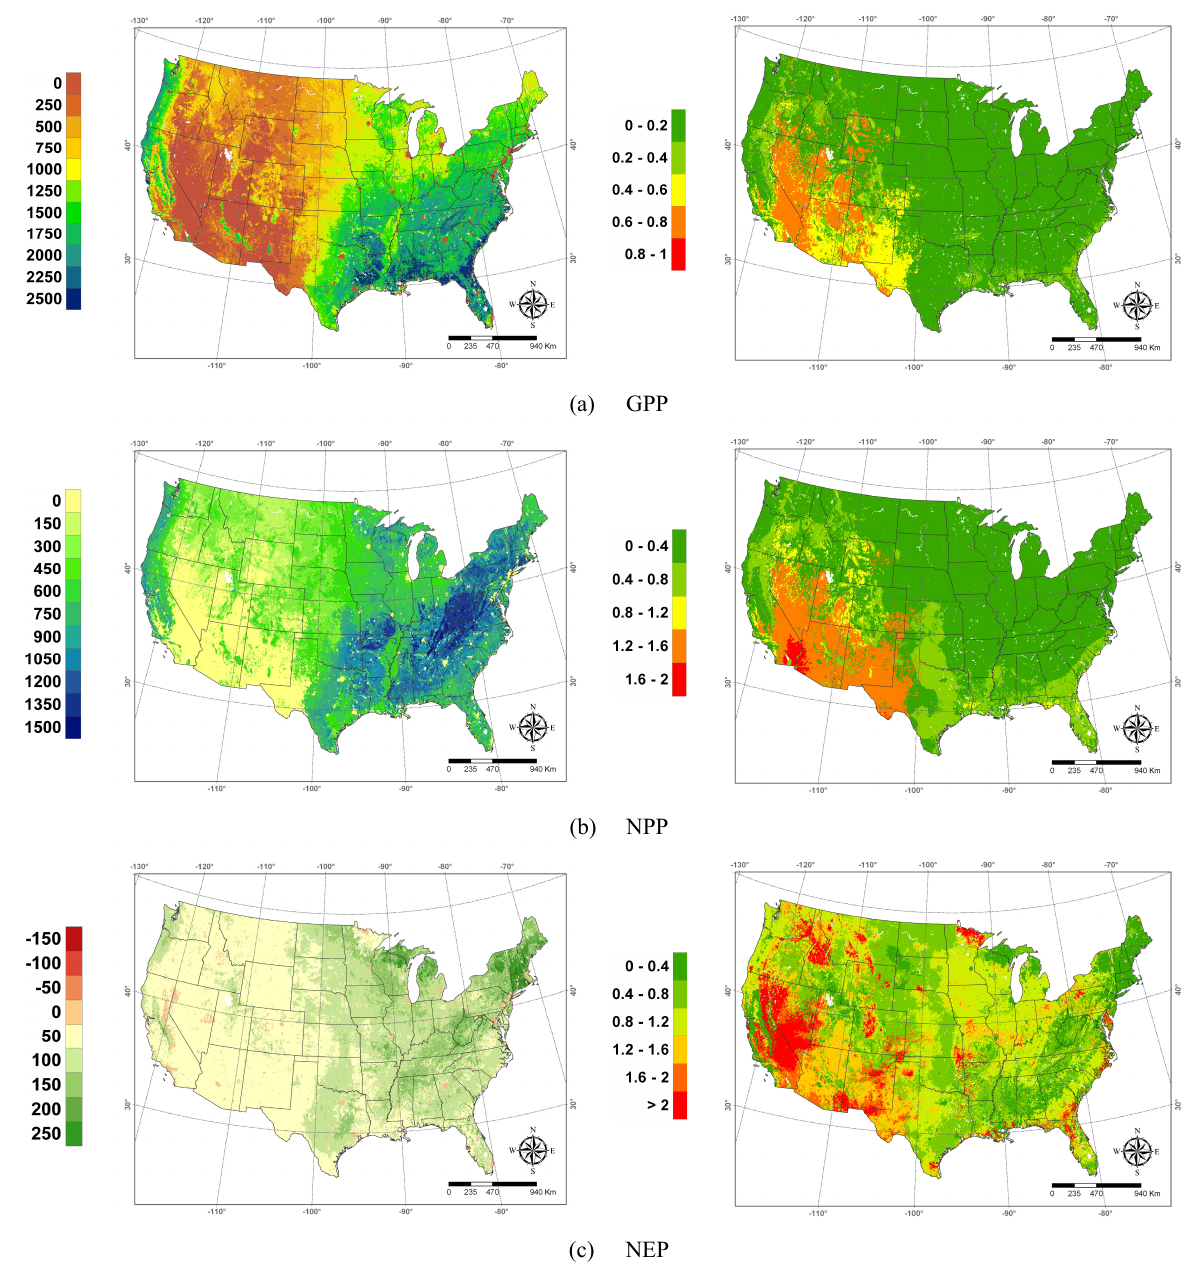
Fig. 7. Average annual carbon fluxes (gCm − 2 yr − 1 ) (left) and the relative standard deviations (right) of the conterminous United States over the period 2000–2005: (a) GPP; (b) NPP; (c) NEP. The relative standard deviations are calculated by dividing standard deviations by the average values of the regional results of the 50 sets of